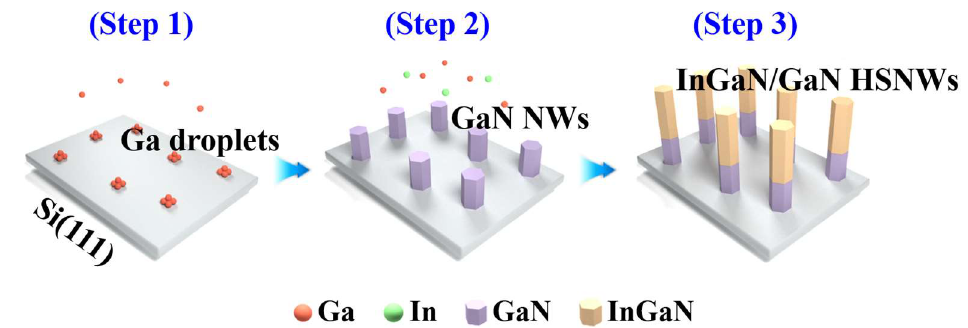
Figure 1. Schematic diagram for the growth of the InGaN/GaN HSNWs.